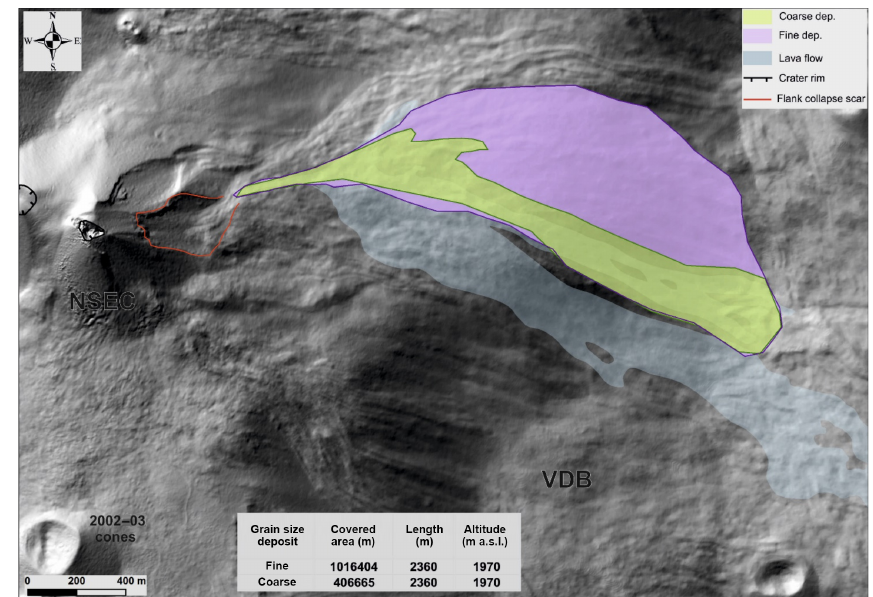
Figure 6. Map of the avalanche deposit from the February 2014 pyroclastic avalanche and the lava flow.